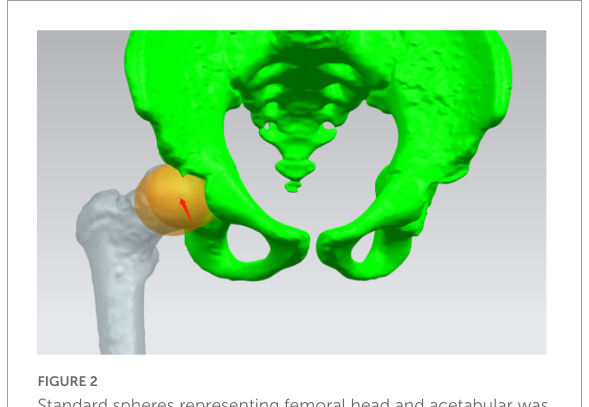
FIGURE2 Standard spheres representing femoral head and acetabular was fitted, respectively. The distance between centers of the two spheres was measured (red arrow).